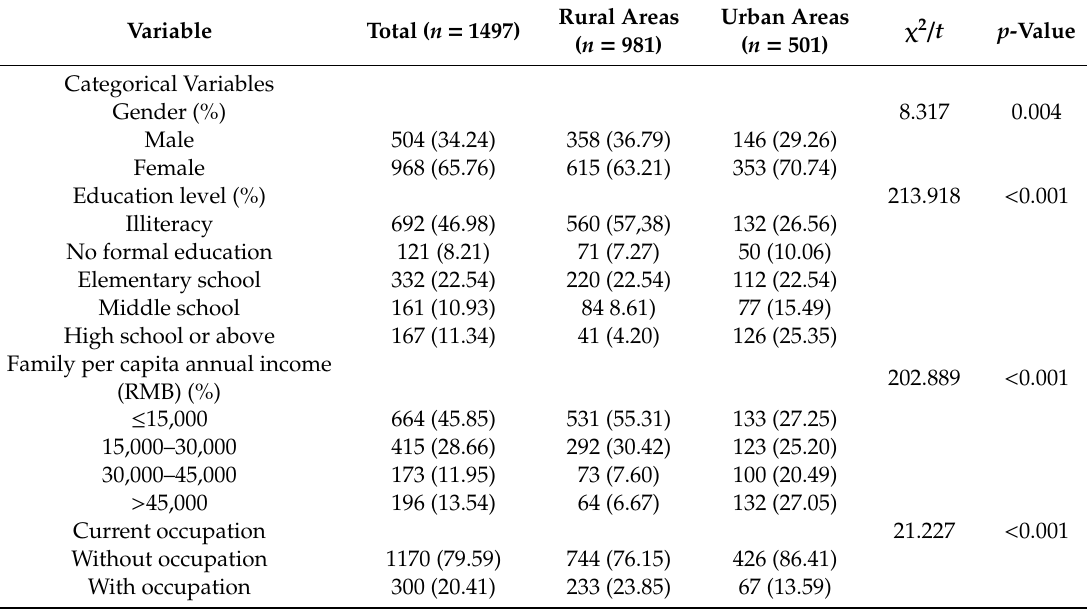
Table 1. Characteristics of the study